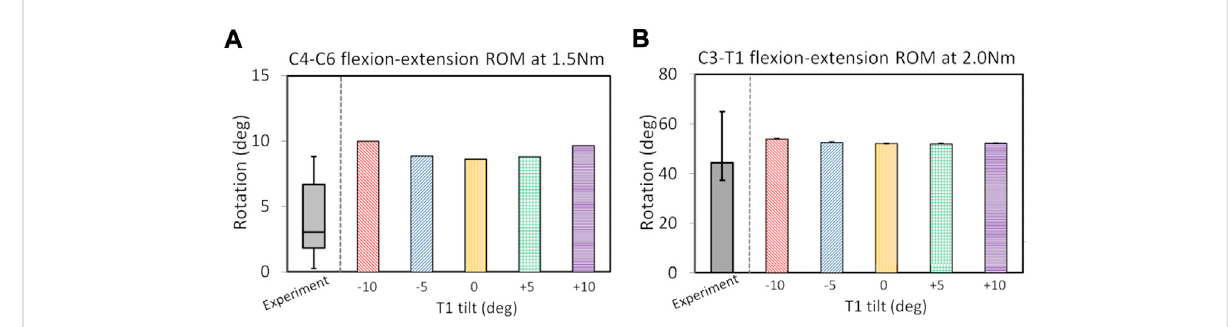
FIGURE 2 ROM validation under pure fl exion – extension loadings for postoperative C2 – T1 FE models of different T1 tilts against experimental measurements:forC4 – C6segment (A) andC3 – T1segment (B) .Theboxplotin (A) depictstheminimum,25%percentile,median,75%percentileand maximum values from (Hartmann et al., 2015); the error bar plot in (B) depicts the 25% percentile, median and 75% percentile values from (Aghayev et al., 2014).